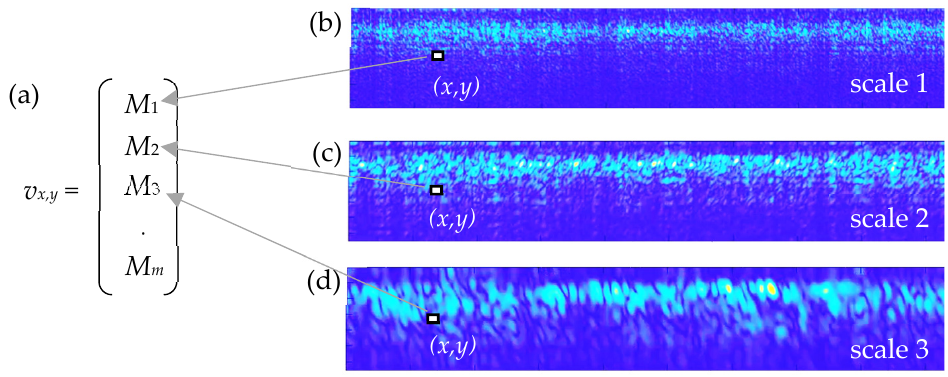
Figure 6. Pixel-wise definition of ( a ) a feature vector v x,y from Gabor filter maps at various resolution levels ( b – d ), representing different frequency content from high-frequency ( M 1 ) to successively lower frequency content ( M 2 , M 3 ,…, M m ). Colors indicate different filter response magnitudes.